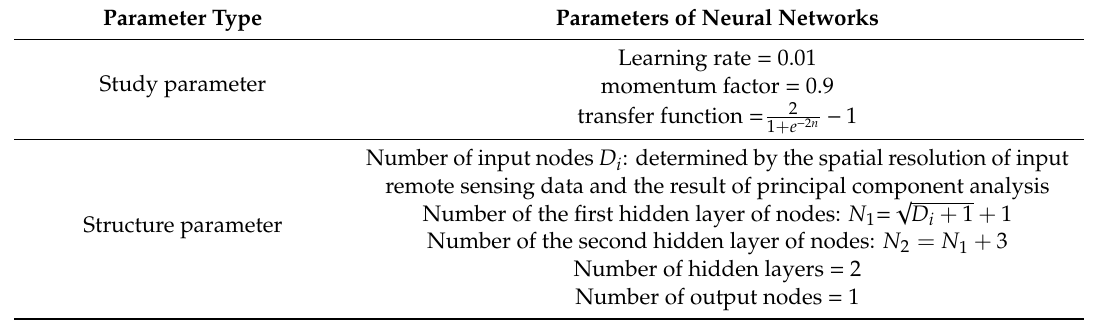
Table 5. Cross-correlation function (CCF) between rainfall data and water level.